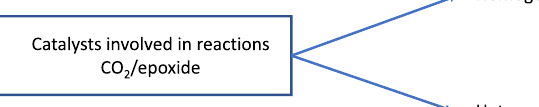
Fig. 6. Different kinds